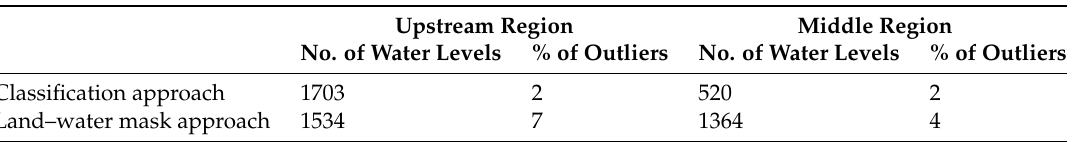
Table 4. Comparison of the two approaches for CryoSat-2 water levels in terms of absolute number of water levels and number of